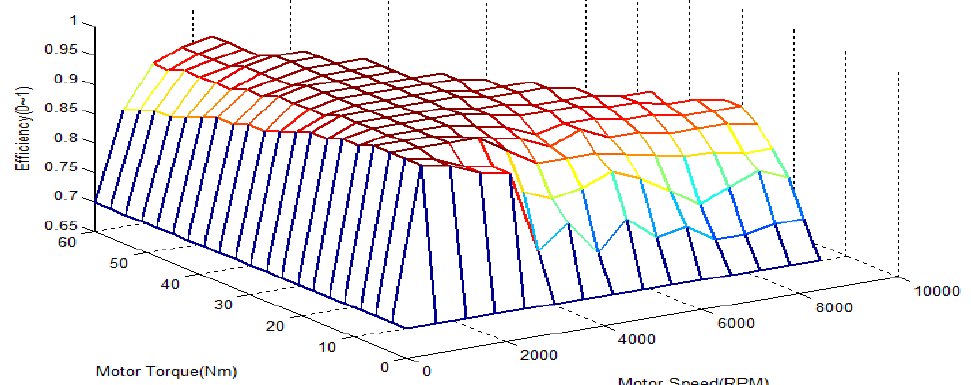
Figure 2. Motor efficiency characteristic curve.